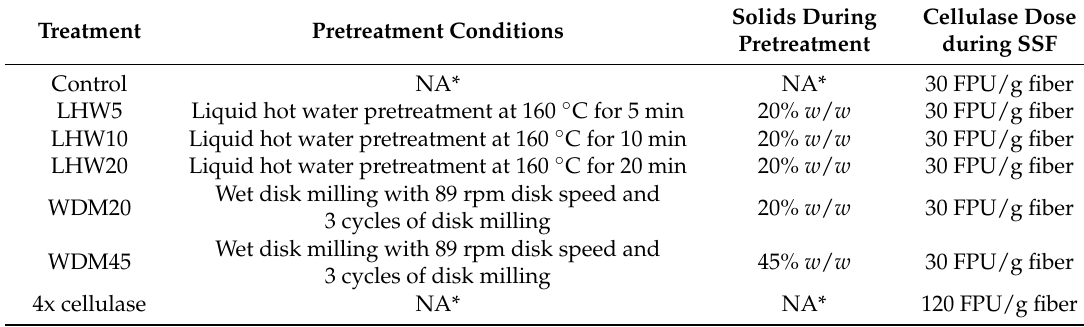
Table 1. Description of treatments investigated for conversion of fiber into